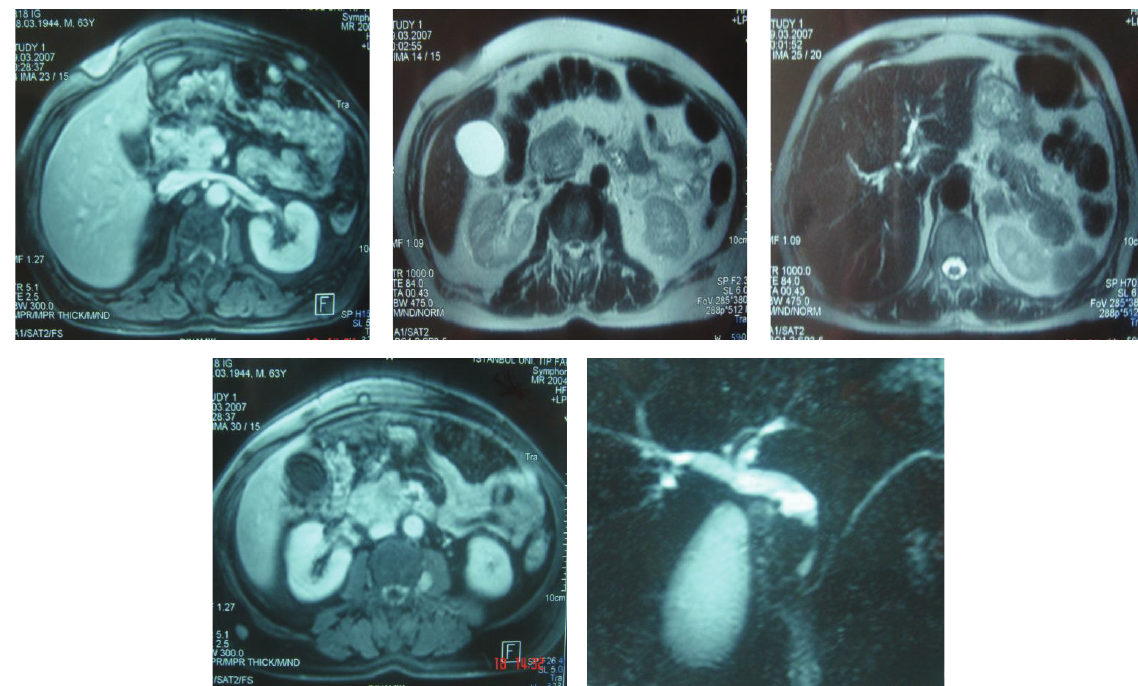
Figure 2: Multiple intra-abdominal lesions involving pancreas, adrenal glands. Common bile duct is dilated.